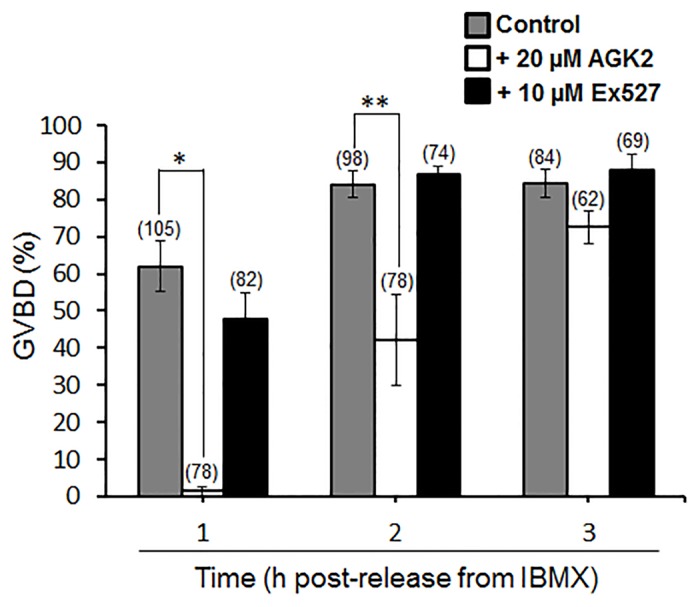
GVBD rates for AGK2- and Ex527-treated oocytes following release from IBMX.Fully-grown GV-stage oocytes were cultured in IBMX-containing medium treated with either 20 μM AGK2 or 10 μM Ex527 or left untreated. Rates of GVBD were scored at 1 h, 2 h and 3 h following release from IBMX (* P < 0.0001, ** P = 0.0002; Data are mean ± SEM; Analysis by Student’s t-test). Numbers of oocytes for each group are shown in parentheses and are pooled data from 3 replicate experiments.